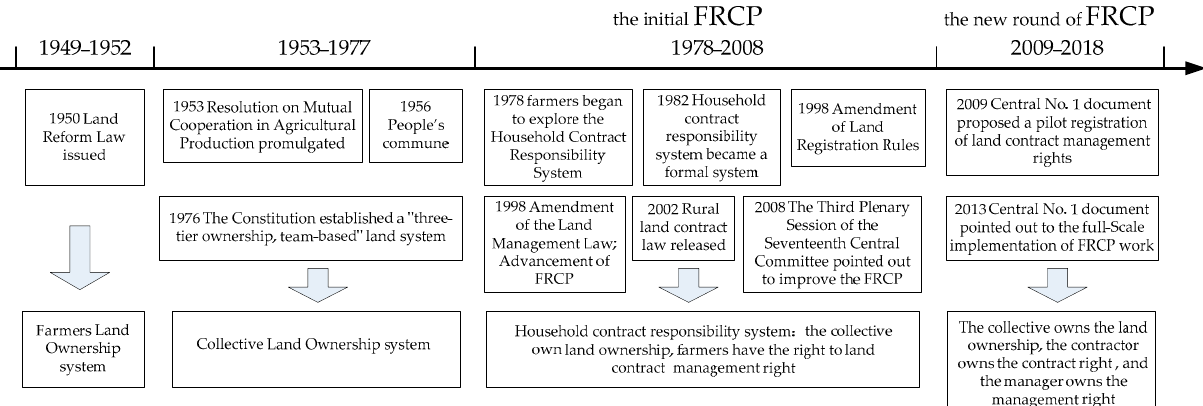
Figure 1. Evolutionary process of rural land rights system reform in China since 1949.